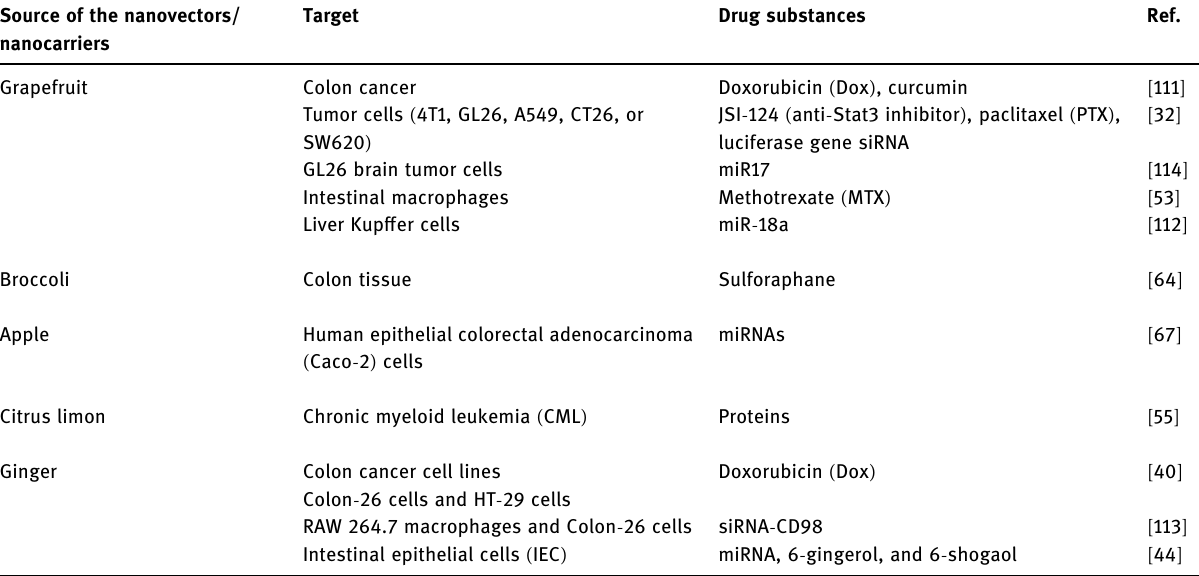
Table 3: PDNVs as drug carrier Source of the